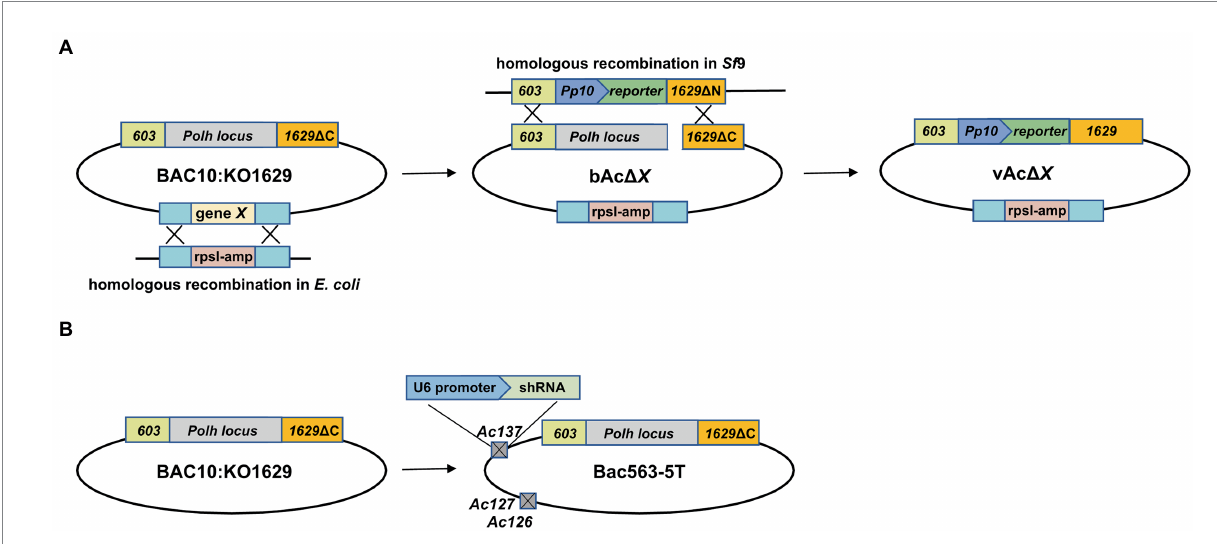
FIGURE 1 Schematic diagram of the construction of bacmids and generation of AcMNPV expressing a reporter gene. (A) Generation of fragment-knockout (KO) bacmid and AcMNPV expressing a reporter gene. DNA fragment containing predicted nonessential genes (gene X) was deleted from the AcMNPV bacmid BAC10:KO1629 by replacing the target fragment with a rpsl-Amp cassette via homologous recombination in E. coli strain HS996, and the KO bacmid was named as bAc Δ X. The recombinant virus carrying the reporter gene expression cassette at the polyhedrin locus, vAc Δ X, was generated in Sf 9 cells by co-transfection with the linearized bAc Δ X and pTriEx plasmid. The parental virus vAc generated from BAC10:KO1629 was used as a control in this study. (B) Schematic diagram of Bac563-5 T used in this study. Bac563-5 T was modified from BAC10:KO1629 by knocking out ChiA/v-cath ( Ac126-127 ) and p10 ( Ac137 ) and inserting an shRNA expression cassette at the Ac137 locus to inhibit the virus infection-induced apoptosis (Je et al., 2001a; Zhang et al.,